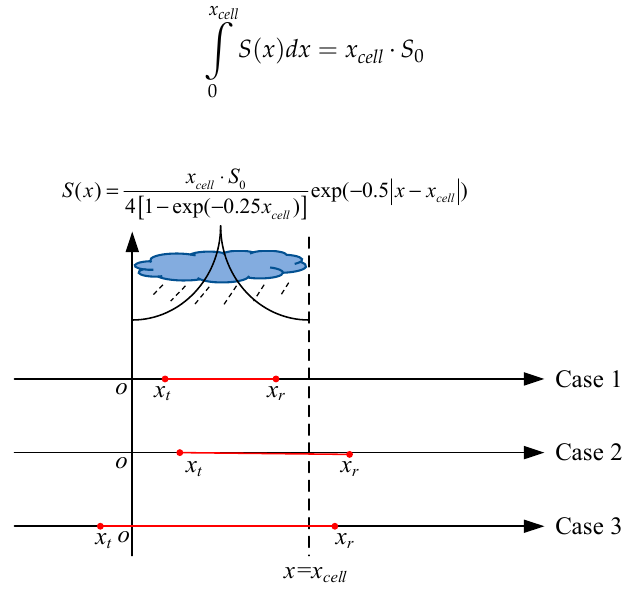
Figure 7. The schematic diagram of the precipitation cell model and link distribution under three cases.